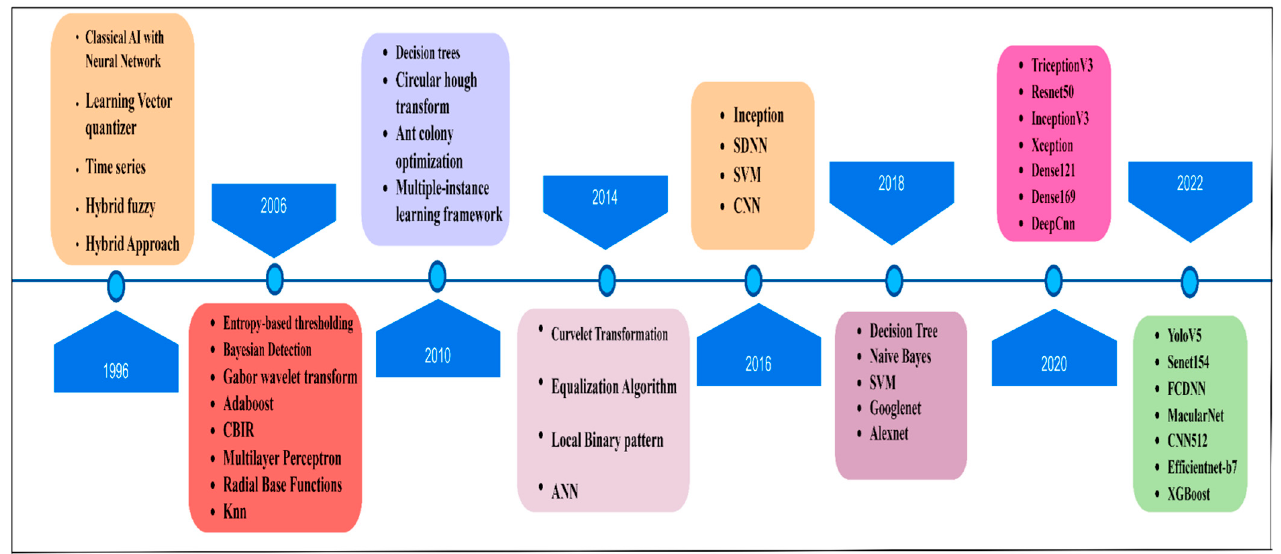
Figure 6. Evolution of DR with artificial intelligence.